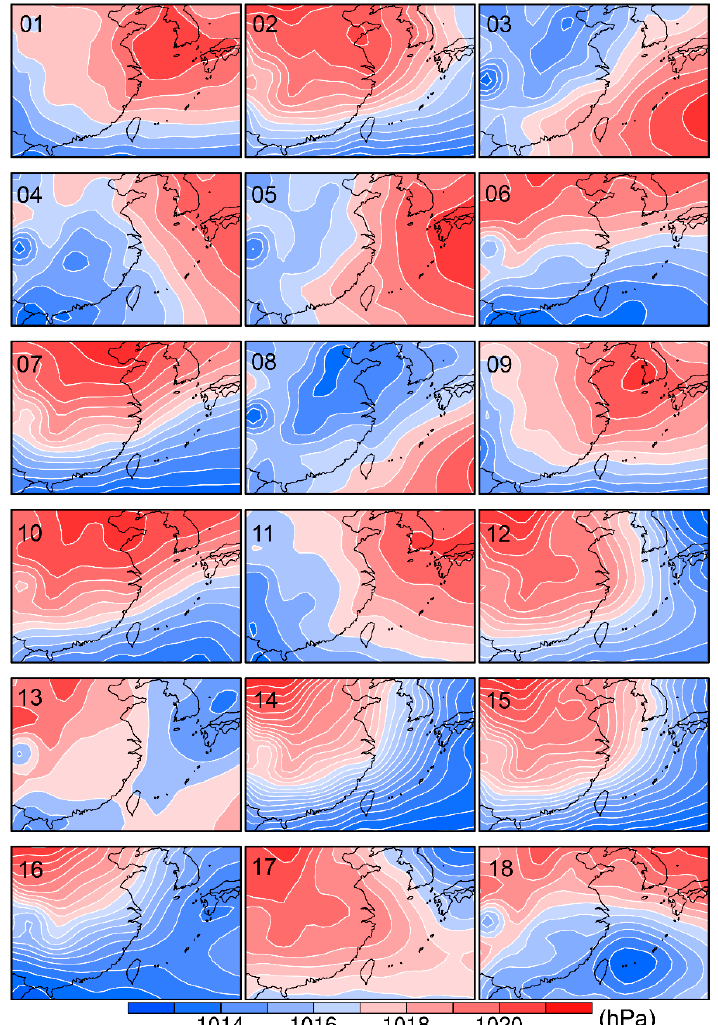
Figure 1. 18 weather types created by classification.